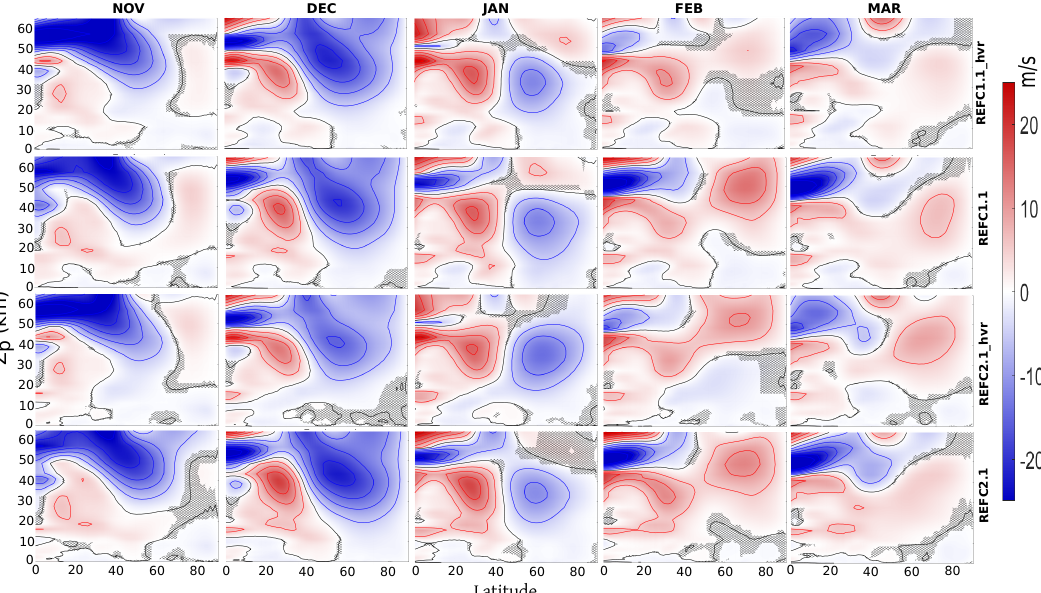
Figure 5. Monthly differences in the zonal average of the wind component u between model and reanalysis. Positive values indicate that the model has stronger winds than the reanalysis, and negative values indicate that the model has weaker winds than the reanalysis. Contour lines are at intervals of 5 m/s. Cross-hatched regions indicate statistically non-significant values (Student’s t -test with p >